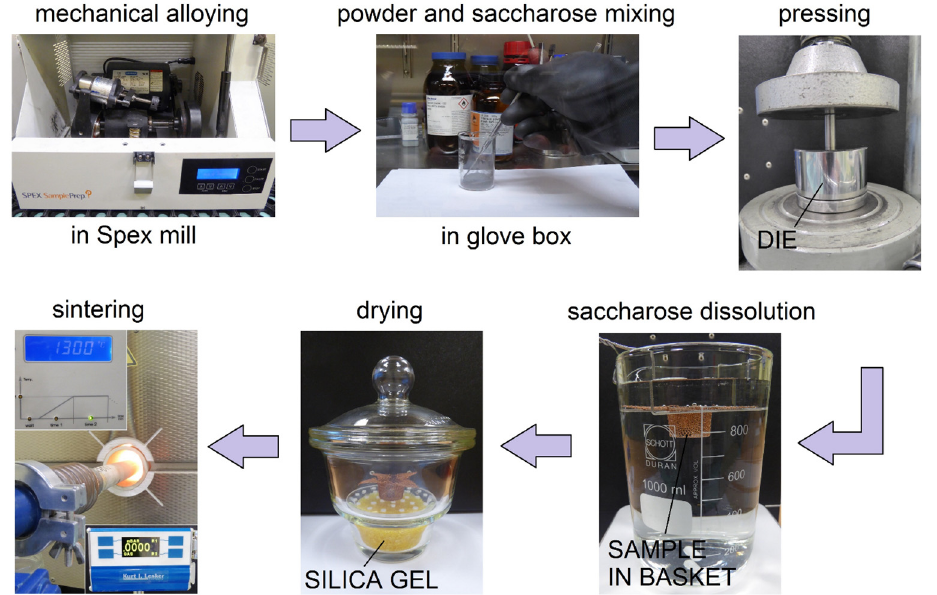
Figure 1. Overview of titanium-45S5 Bioglass foam